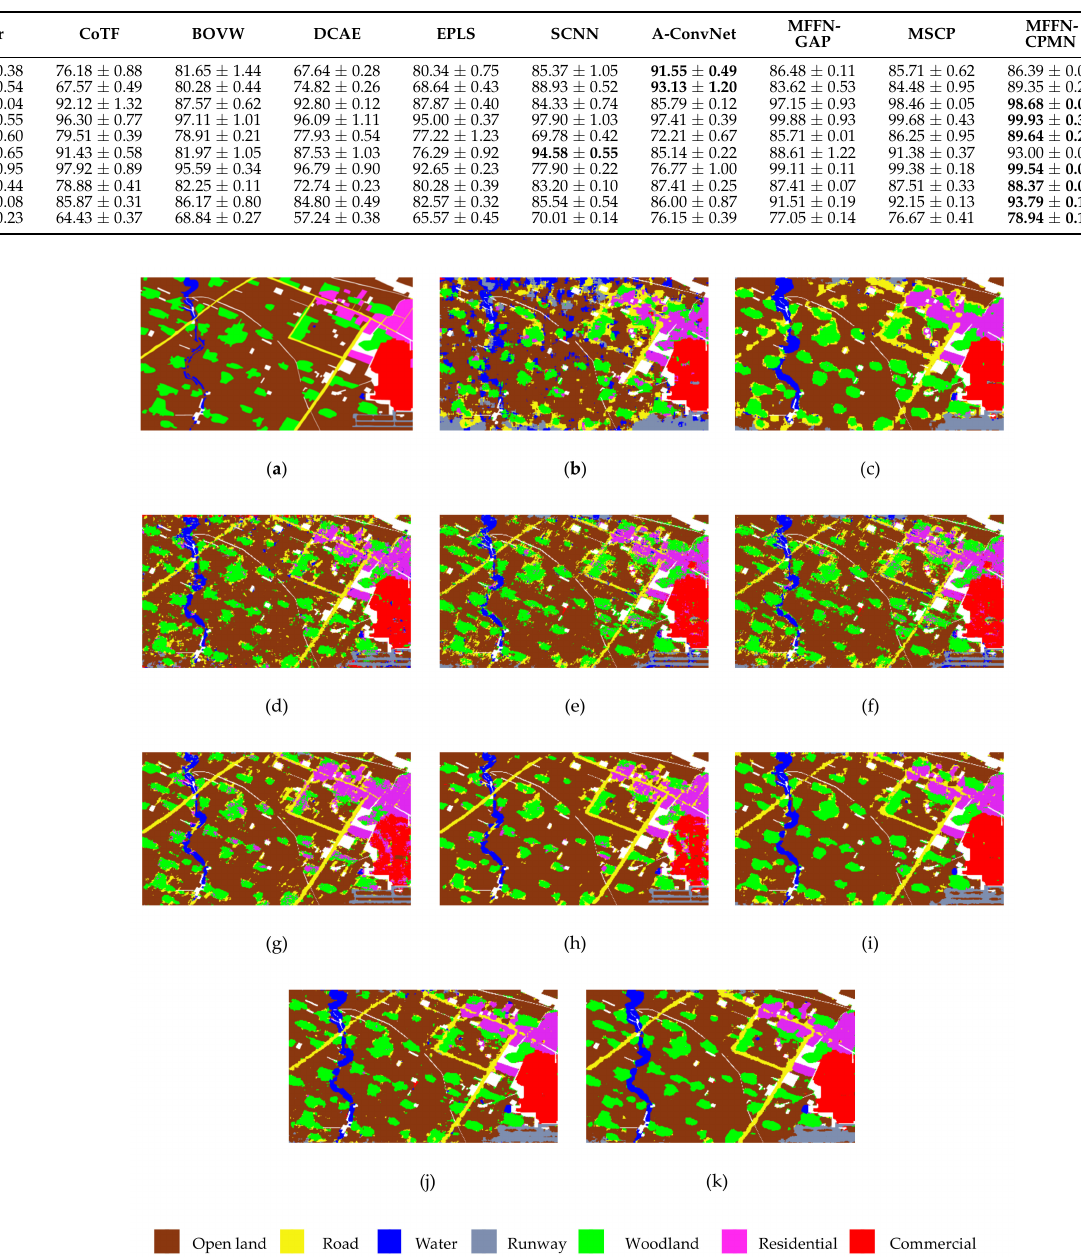
Figure 14. Classification maps of Chinese airborne SAR image with different methods. ( a ) Ground- truth. ( b ) Gabor. ( c ) CoTF. ( d ) BOVW. ( e ) DCAE. ( f ) EPLS. ( g ) SCNN. ( h ) A-ConvNet. ( i ) MFFN-GAP. ( j ) MSCP. ( k )